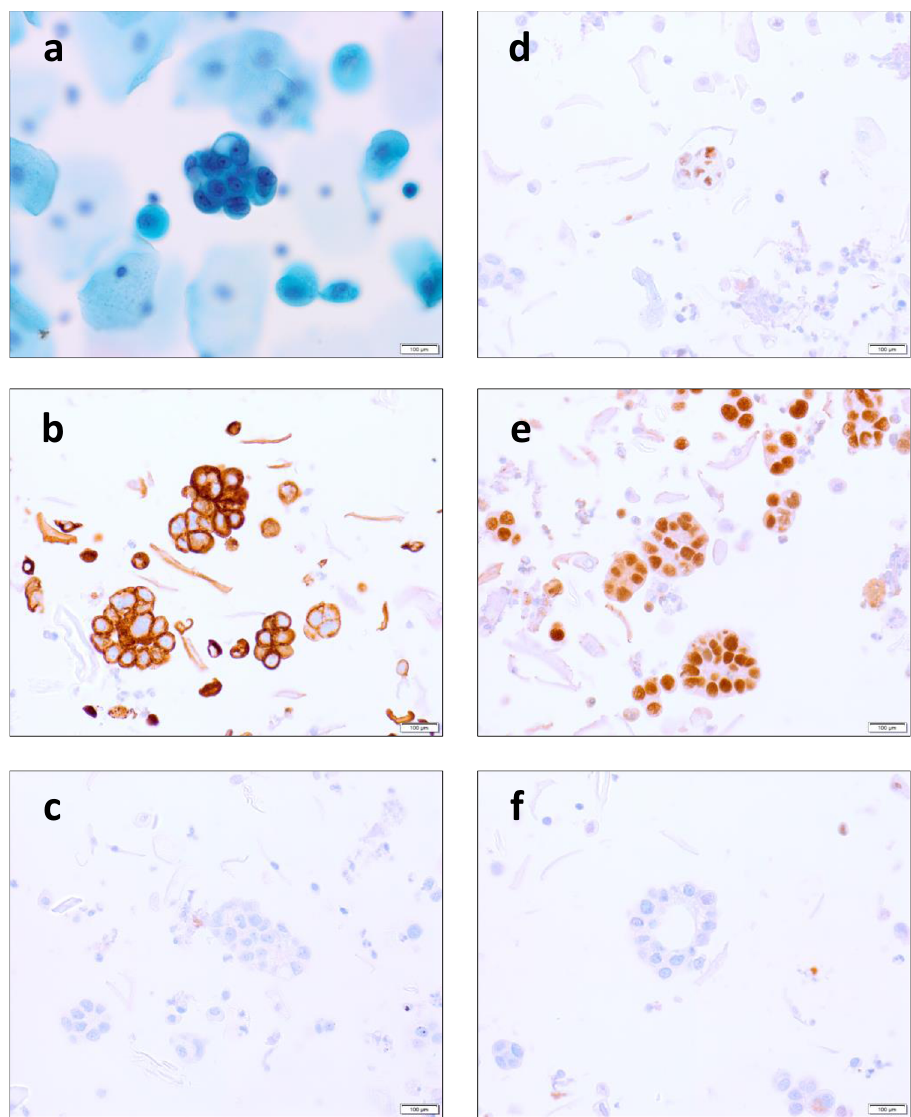
Fig. 2 Photomicrograph showing morphology and immunohistochemistry pro fi le of endometrial cancer cells in urogenital samples. a Urine sample showing positive urine cytology (SurePath), demonstrating a single cluster of endometrial cells with malignant features, including enlarged hyperchromatic nuclei, coarse chromatin, prominent nucleoli, irregular nuclear outlines and high nuclear-to-cytoplasmic ratio. b – f Vaginal sample demonstrating the immunopro fi le of these cells, consistent with epithelial cells from the female genital tract, CK7 + ( b ), CK20 − ( c ), ER + ( d ), PAX8 + ( e ), GATA3 − ( f ). Scale bar = 100 μ